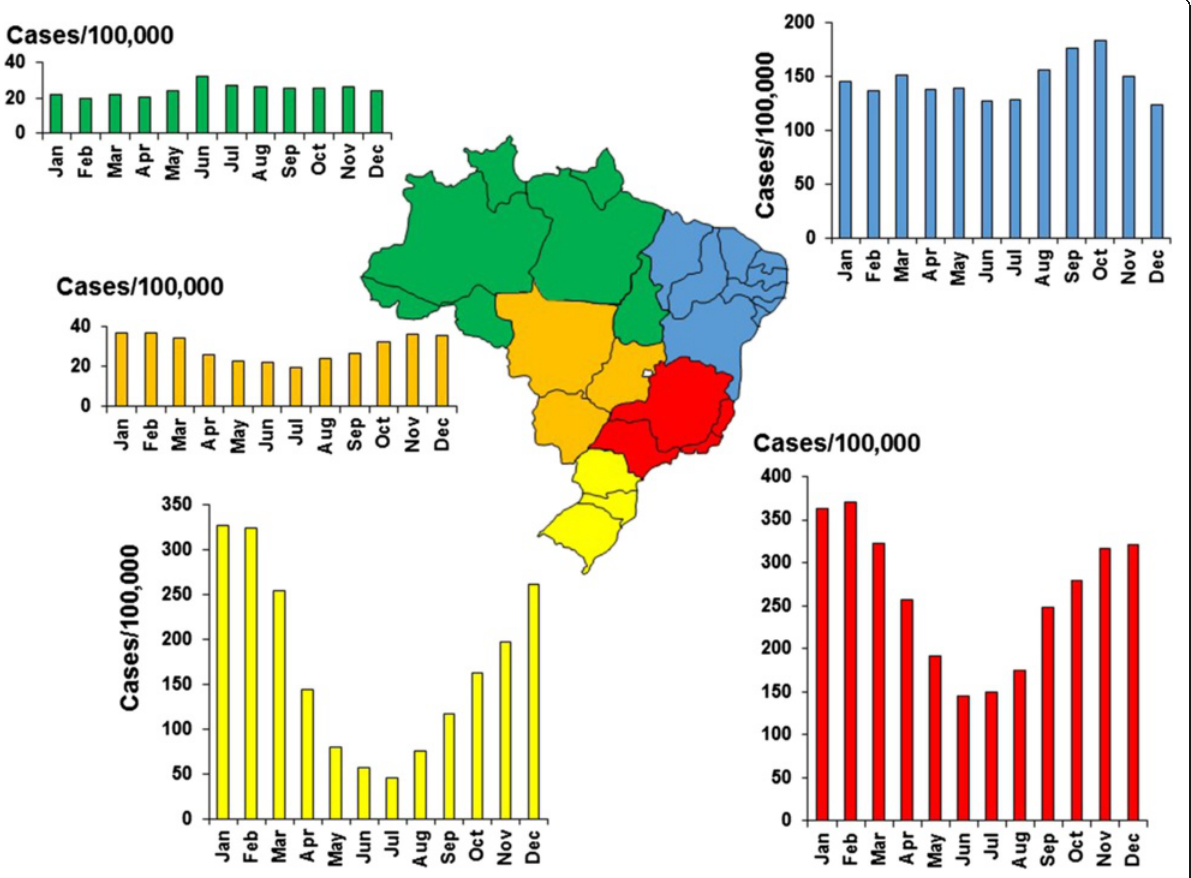
Fig. 10 Seasonal incidence of bee stings according to the